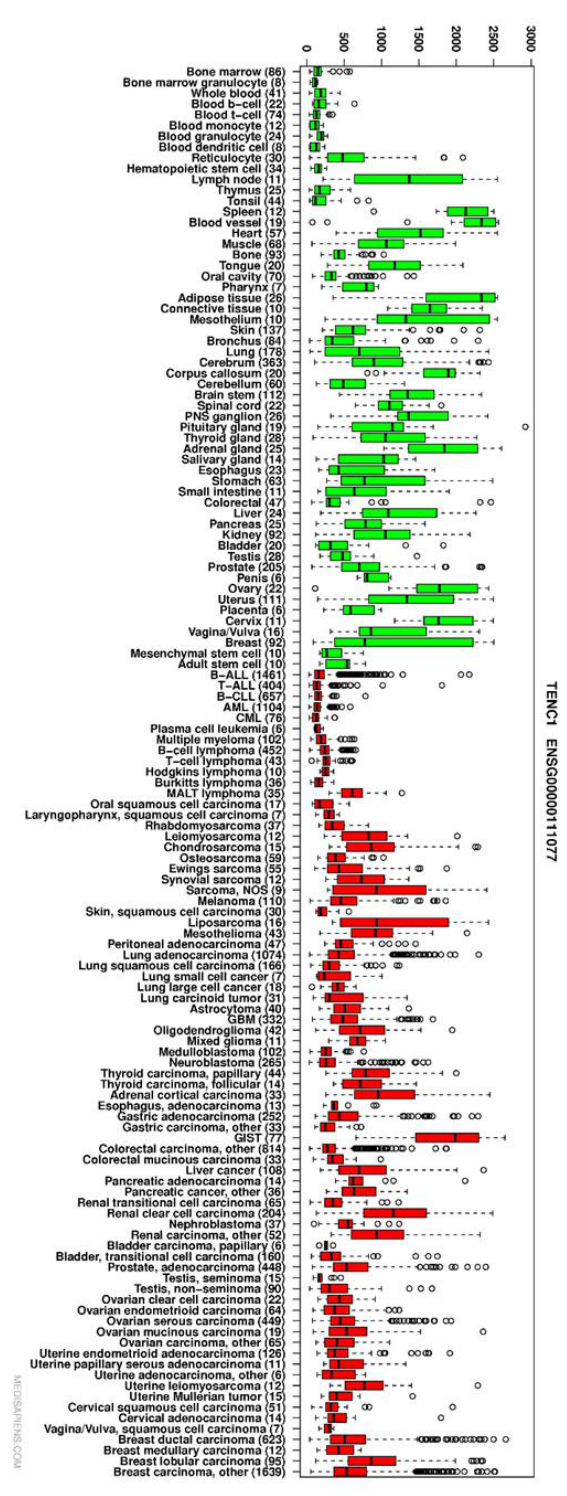
Figure A1. Relative expression of TNS2 among different cancerous tissues. Numbers after the names of malignancies are sample amounts, and outliers are depicted with circles. Data from the IST database, Medisapiens Ltd. (https://ist.medisapiens.com/, accessed on 15 January 2021).